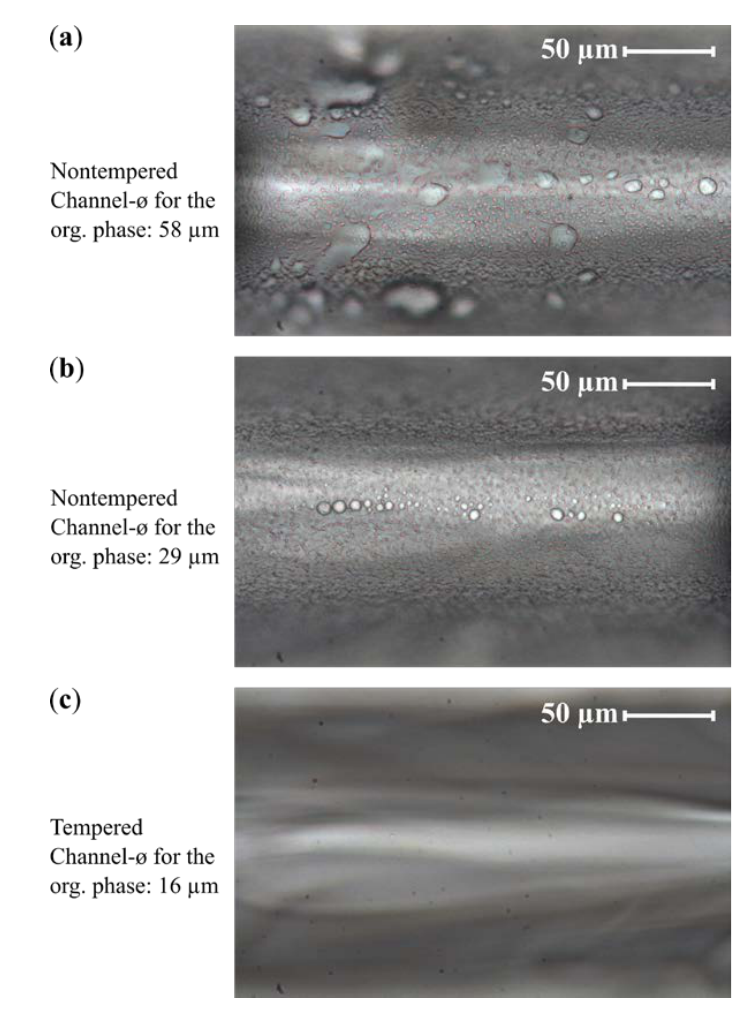
Figure 6. Microscopic images of the main channels of three microfluidic systems taken after 2 min of continuous operation at positions 40 µm after the intersections. The first microsystem ( a ) was made with an organic phase inlet channel of nominally 58 µm in diameter and the second microsystem ( b ) of nominally 29 µm. The third microsystem ( c ) had a nominally 29 µm inlet channel diameter before further treatment was tempered at 760 °C for one hour; after that it exhibited an organic phase inlet channel of 16 µm in diameter and smoothed channel walls. In the first microsystem, strong fouling occurred, while in the second microsystem, the fouling was decreased due to more focused injection, but small droplets were still found. In the tempered microsystem, no droplets could be found on the channel walls. The small black dots in the images are background dust particles (they appear identically in all three images).